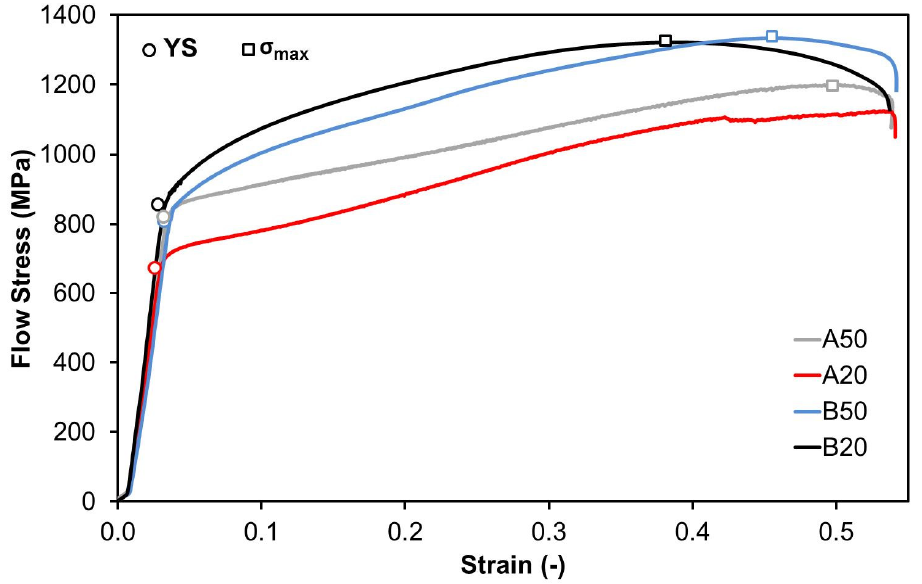
Figure 8. The samples after compression test.